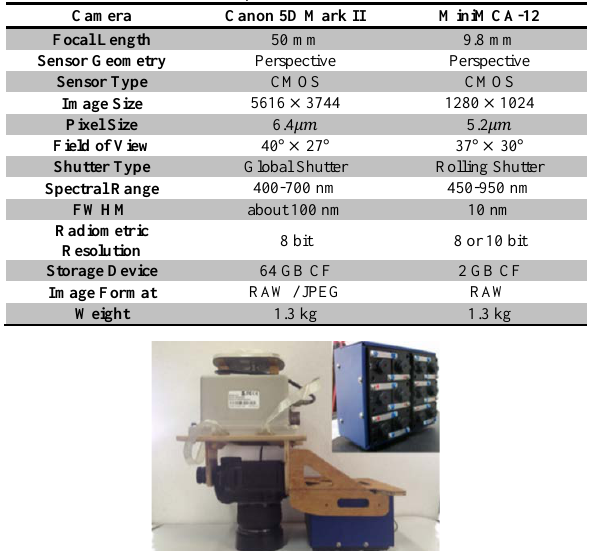
Table 1. Canon 5D Mark II and MiniMCA-12